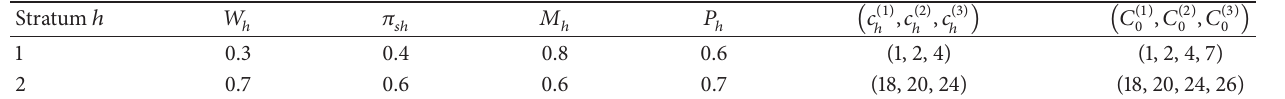
Table 1: Data for two strata.